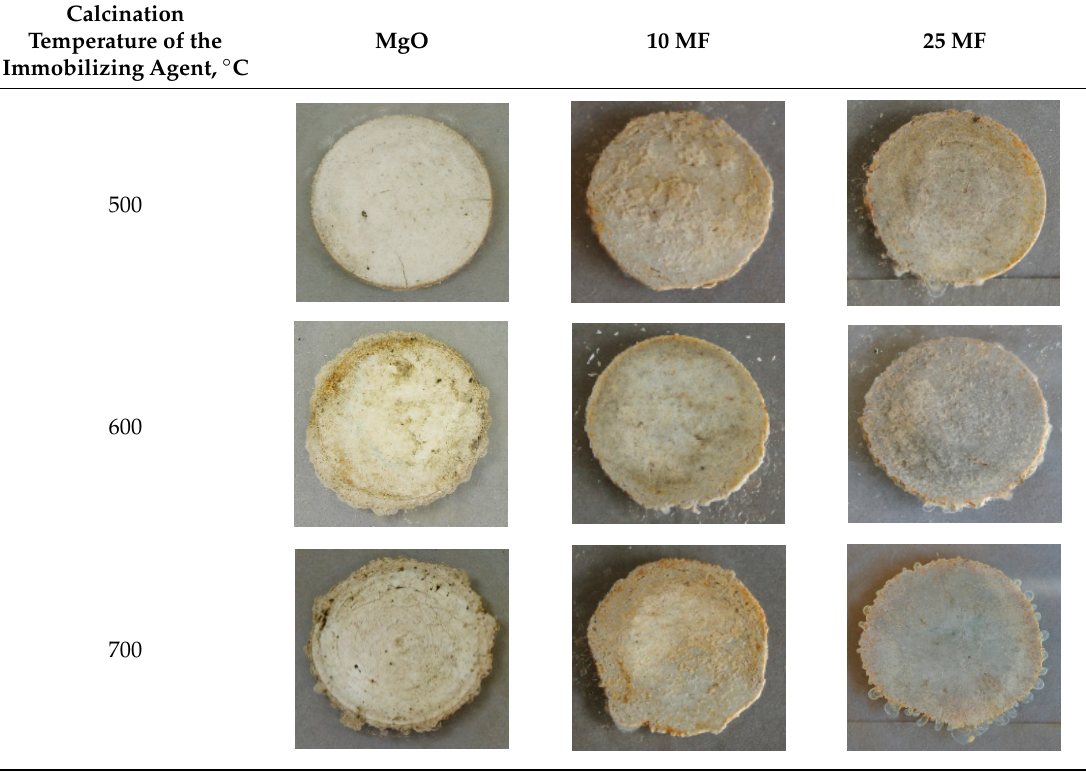
Table 3. Photographs of pellets consisting of electrolyte and immobilizing agents: MgO, 10 MF, or 25 MF, calcined at 500, 600, and 700 °C. The amount of electrolyte: 40 wt.%. Calcination Temperature of the